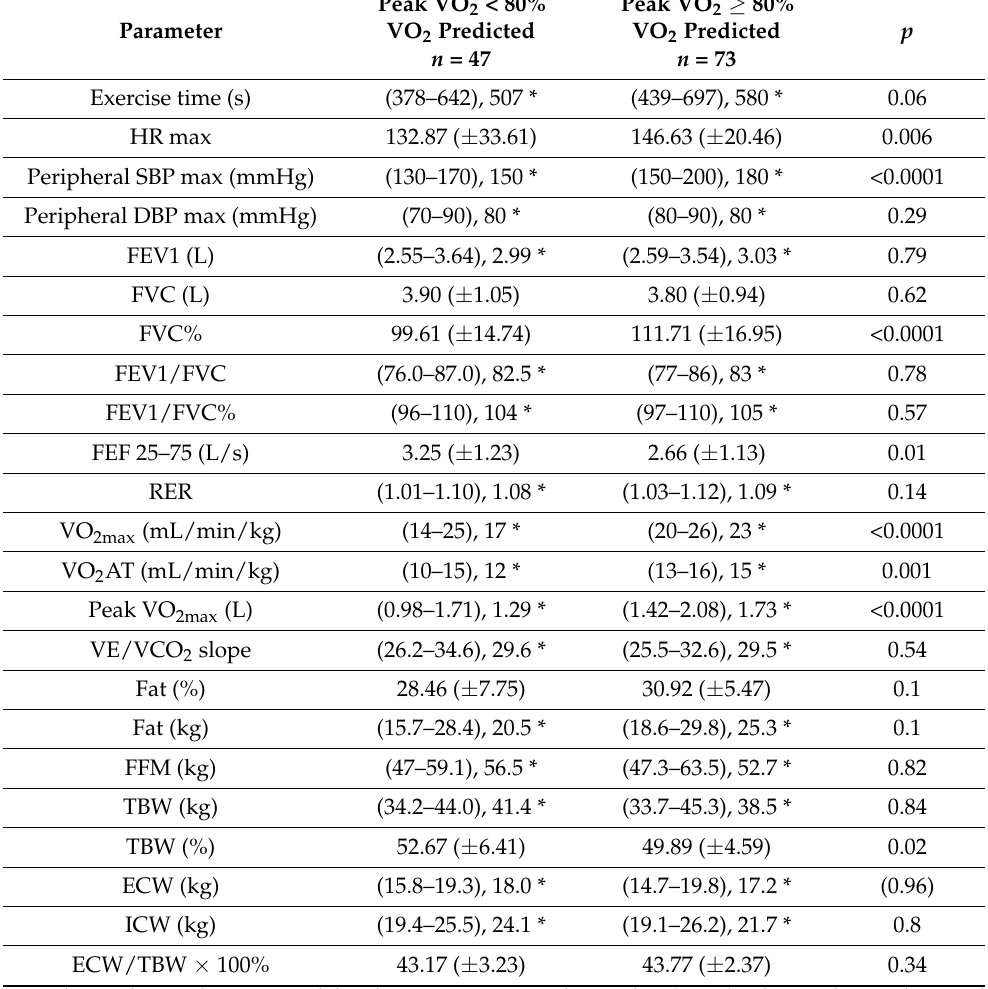
Table 2. Evaluation of spiroergometry and body mass analysis among the investigated